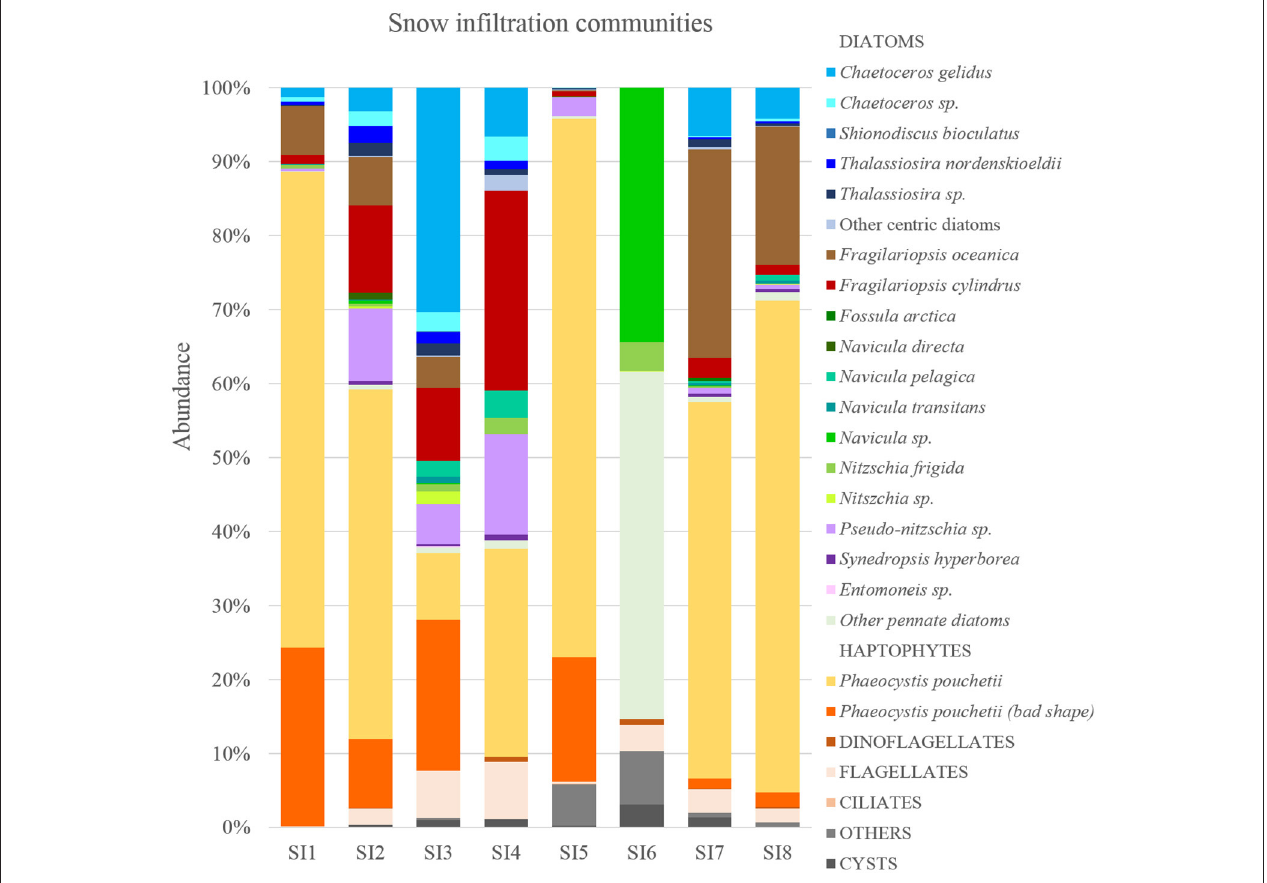
FIGURE 8 | Relative composition of eight different snow infiltration communities based on cell abundance. Samples analyzed by light microscopy.